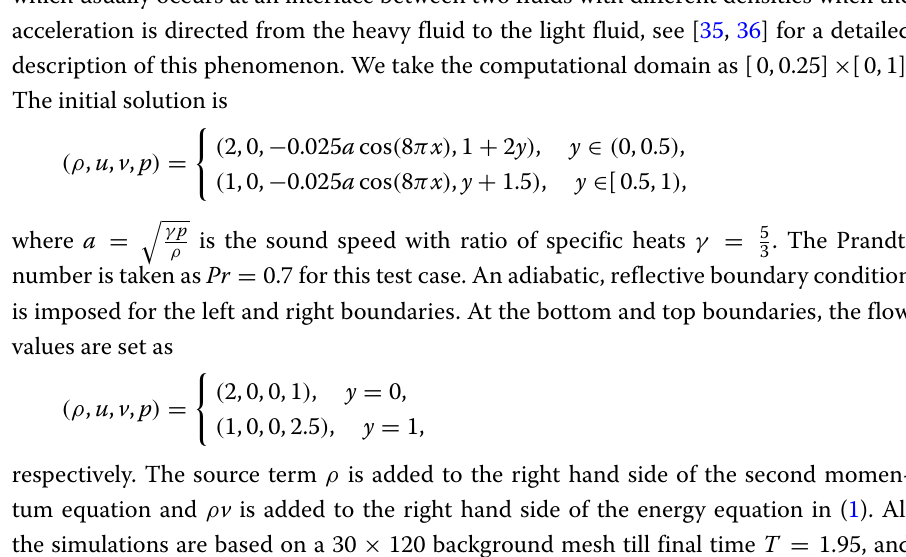
Fig. 13 Pressure coefficient for supersonic flow past a NACA0012 airfoil